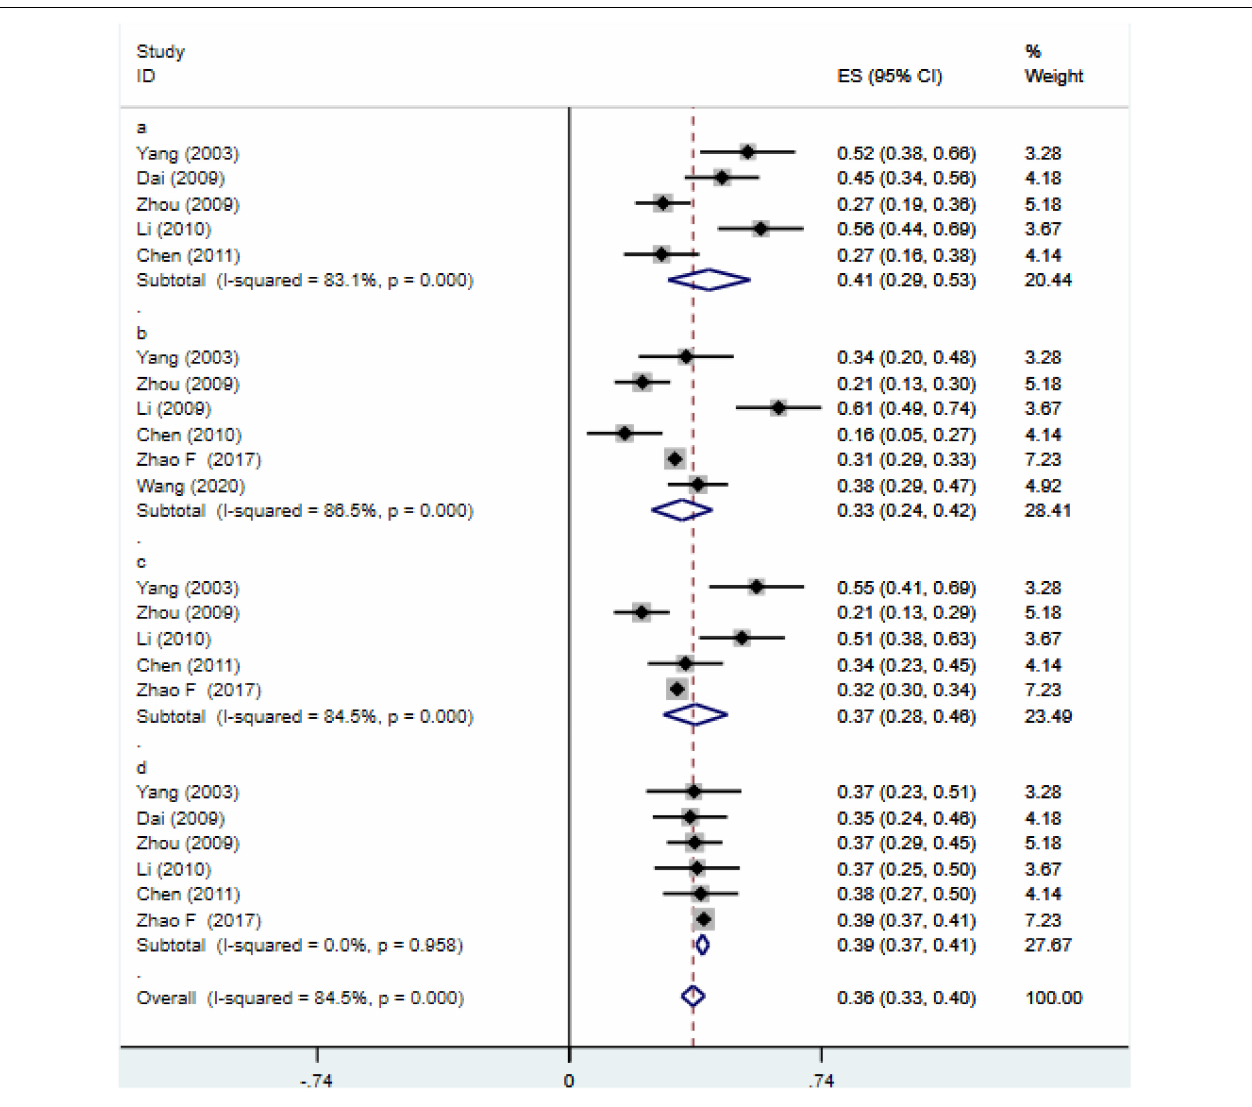
FIGURE 5 | Meta-analysis for the relationship between IAD and subtypes of negative life events. a: interpersonal relationship; b: study pressure; c: punishment; d: